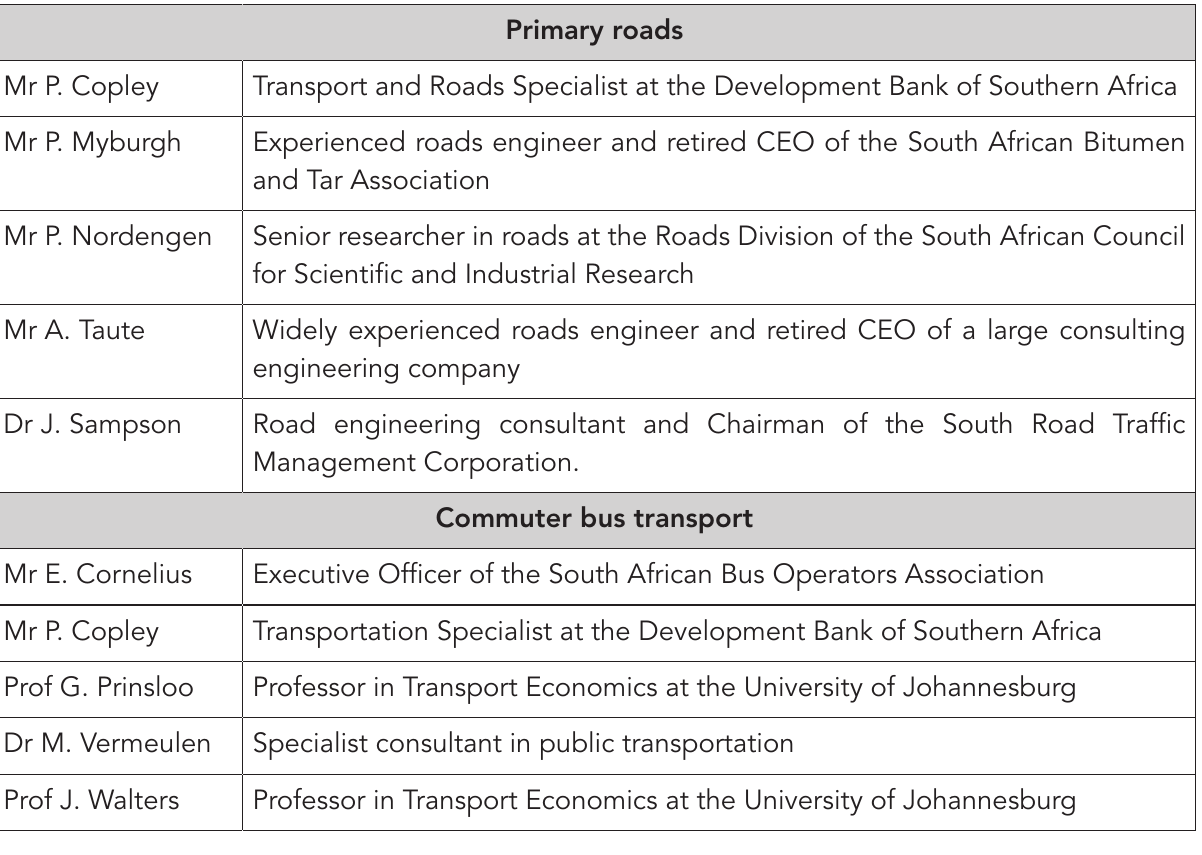
Table A6: Persons consulted for qualitative follow-up explanatory mixed-methods analysis of impact assessment results for primary roads and commuter bus transport policy Source: Compiled for the purposes of this